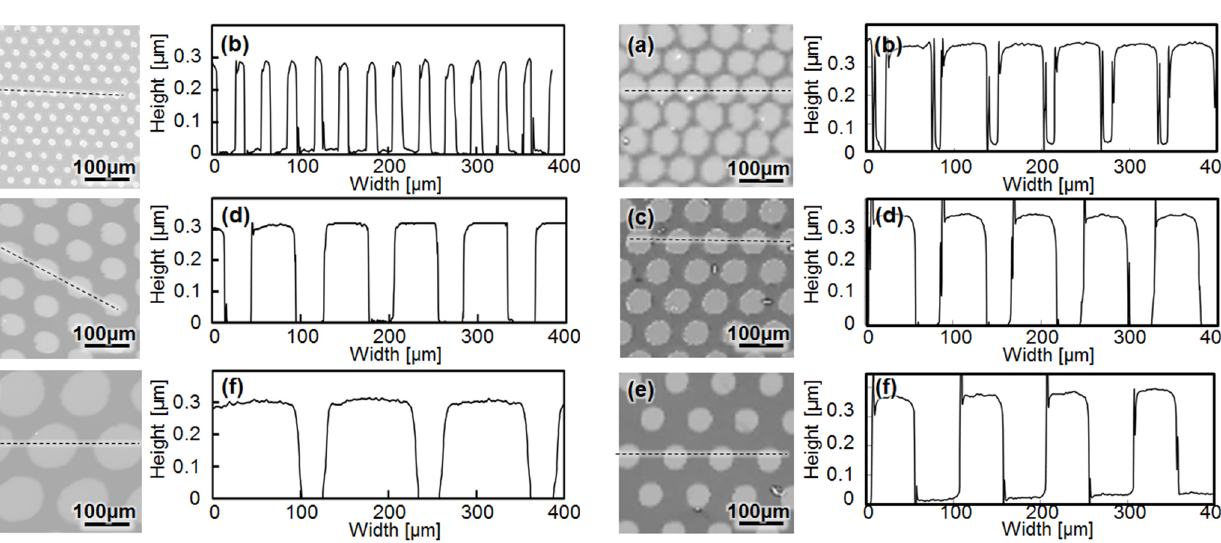
Fig. 3. Microscopic images of micro-textured DLC coatings and their surface pro fi le with a texture diameter of D = 10 m m (a,b), 50 m m (c,d) and 100 m m (e,f) with a constant interspace of l m m. Those dimensions are corresponding to the DLC inter = 30 coverage of 6, 35 and 54%, respectively.